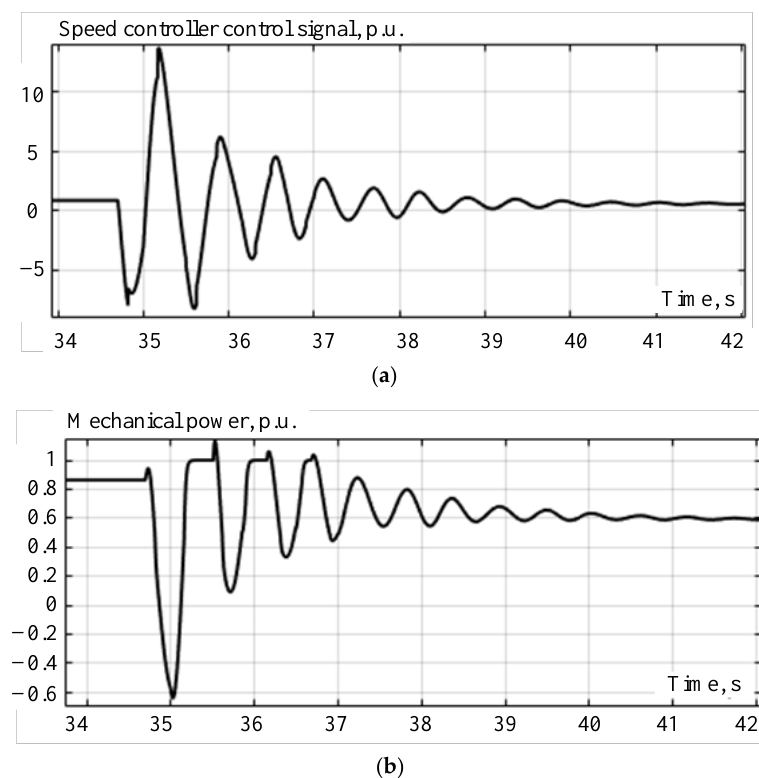
Figure 11. Oscillograms of measured input ( a ) and output ( b ) signals.